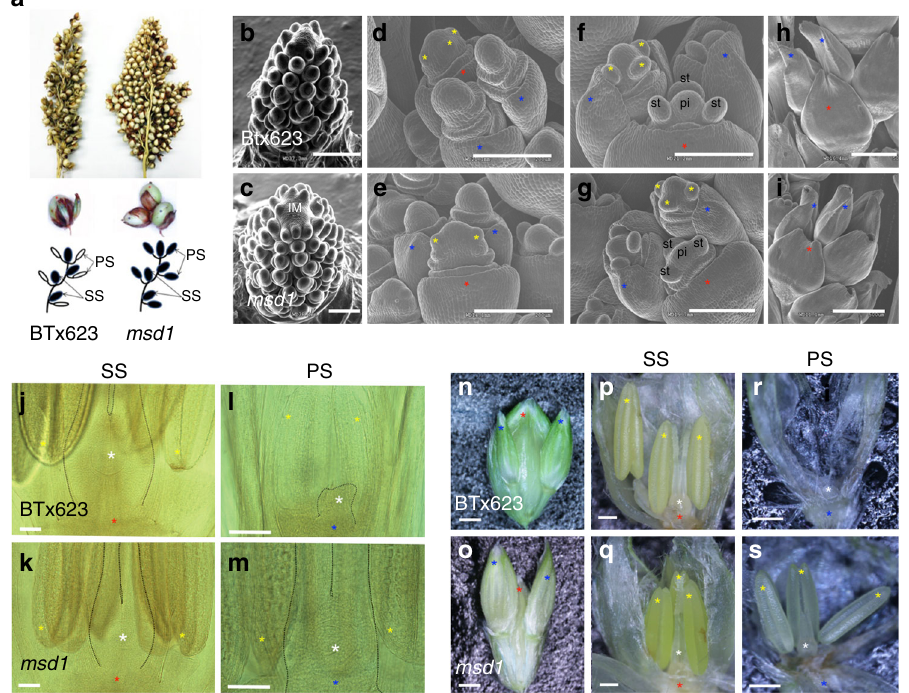
Fig. 1 MSD1 suppresses fl oral organ PS at developmental stage 4. a Photographs of primary branches of the panicle (adaxial side) of BTx623 (wild type, WT) and msd1 . Images immediately below show terminal spikes: WT has one sessile grain, whereas msd1 has three grains, one sessile and two pedicellate. The diagram provides a schematic representation of a secondary branch depicting SS and PS in WT and msd1 : left, WT; right, msd1 . SS sessile spikelet, PS pedicellate spikelet. b – i Detailed scanning electron microscopy analysis of in fl orescence development, comparing WT and msd1 . b , c In fl orescence meristem (IM) of WT ( b ) and msd1 ( c ). Bar: 500 μ m; ( d , e ) fl oral transition in WT ( d ) and msd1 ( e ). Bar: 200 μ m; three young stamen primordia initiate in